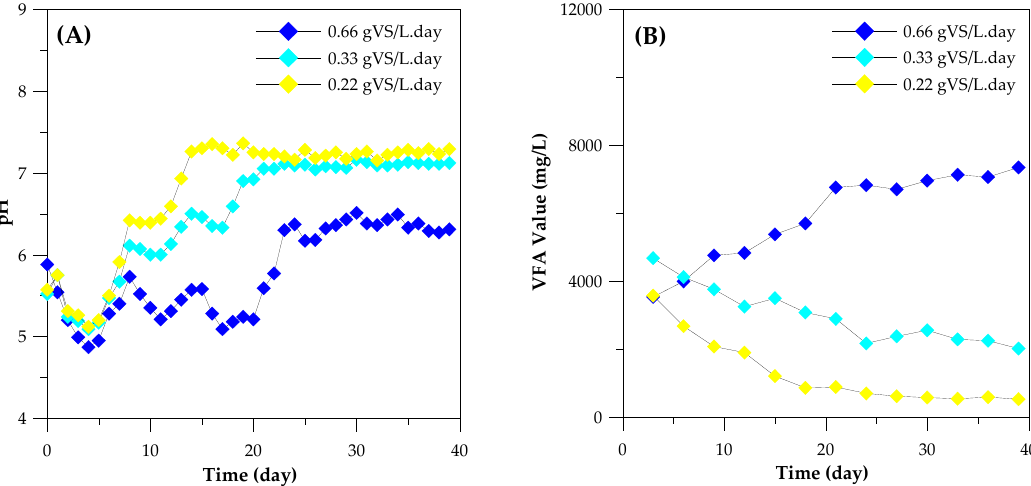
Figure 5. Daily VFAs and pH values for co-digestion of canteen food waste and domestic wastewater in a semi-continuous experiment, showing changes in ( A ) pH and ( B ) VFA value. Table 3. Summary of performance parameters for semi-continuous anaerobic digestion.